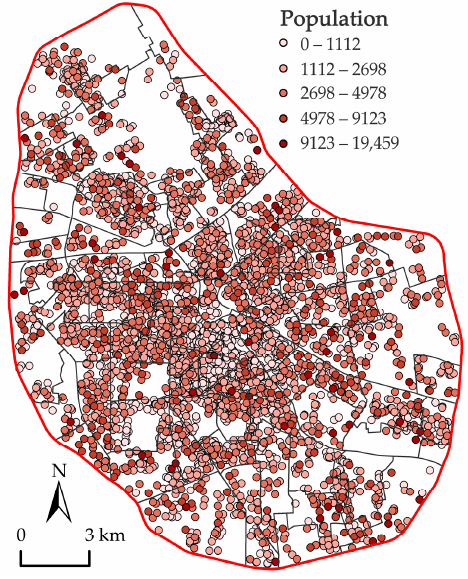
Figure 5. Spatial distribution of population in the research area.